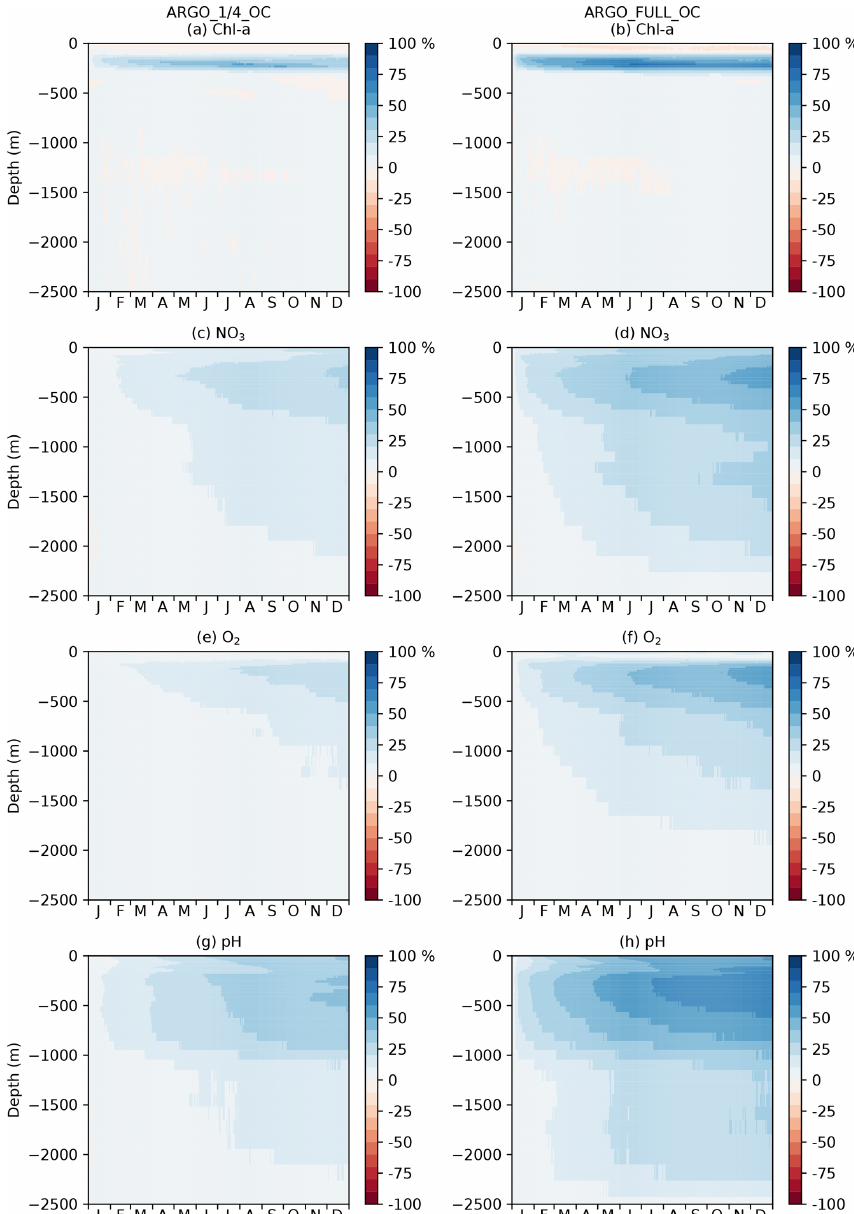
Figure 11. Hovmöller diagram of daily global MAE red_% over OC with depth for Chl a , NO 3 , O 2 , and